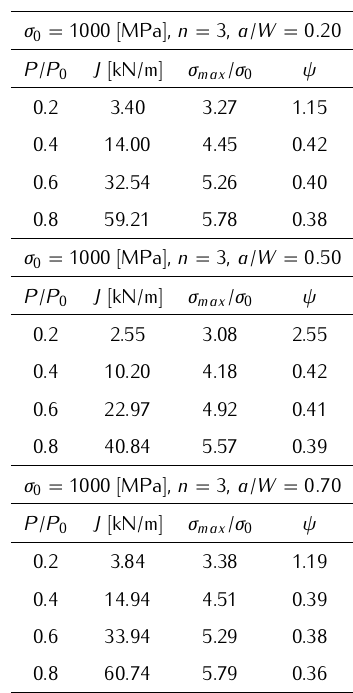
Table C1. Numerical results for CC(T) specimens characterized by yield stress σ MPa and work hardening exponent 0 = 1000 in R-O relationship n = 3